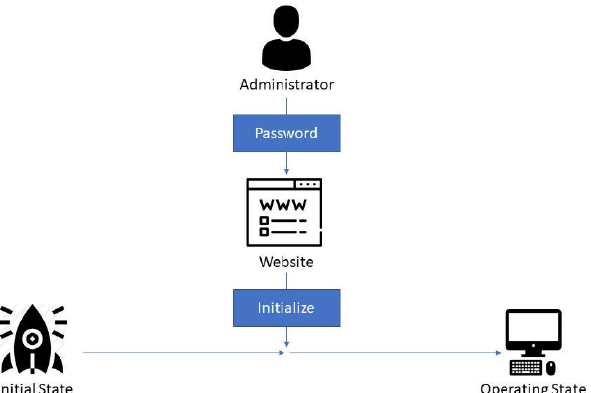
Figure 8. Initialize function: Initial state is the first state in the system. There are neither data nor programs to monitor and protect the server.